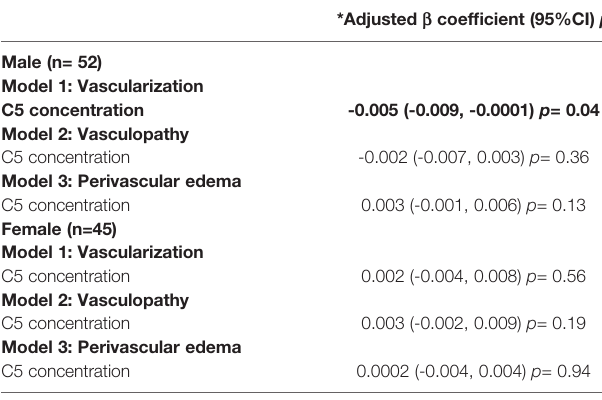
TABLE 6 | Sex-disaggregated multivariate linear regression model estimates for C5 concentration and vascular